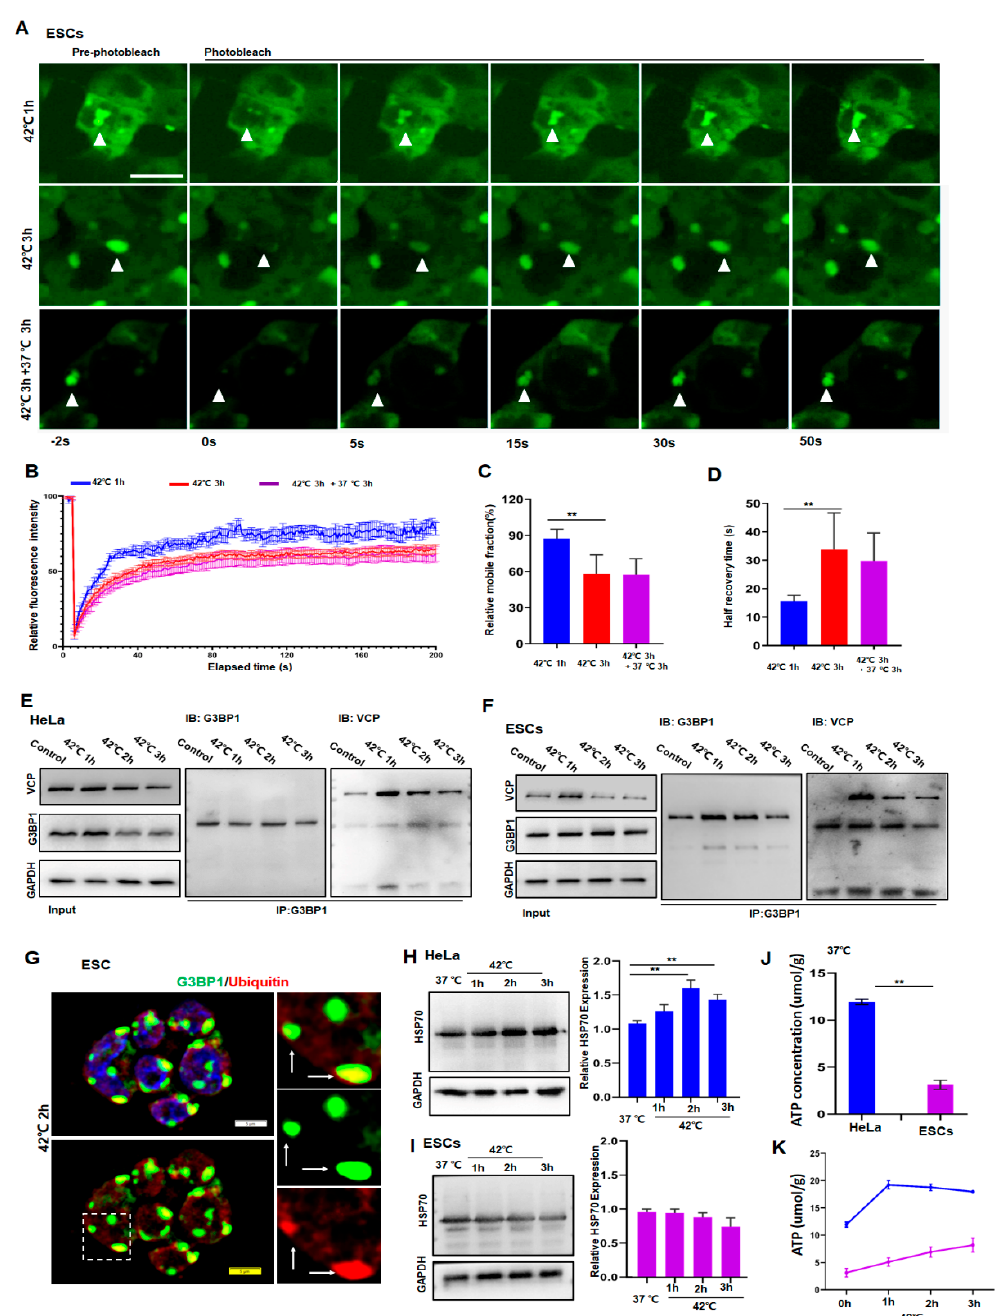
Figure 2. HeLa cells resolved SGs but ESCs failed to do so due to low levels of HSP70 and ATP. ( A , B ) FRAP analysis of G3BP1-SGs in ESCs after 42 ◦ C stress for 1 or 3 h and then recovery for 3 h at 37 ◦ C. n = 15 cells for each group. Mean ± SEM. Scale bar, 10 µ m. ( C , D ) Quantification of mobile fraction and half recovery time in ESCs after 42 ◦ C stress for 1 or 3 h then recovery for 3 h at 37 ◦ C. n = 15 cells for each group. Mean ± SEM. ** p < 0.01 (ANOVA test). ( E ) Immunoblotting of VCP after immunoprecipitation of G3BP1 from HeLa cells after 42 ◦ C stress for the indicated time. ( F ) Immunoblotting of VCP after immunoprecipitation of G3BP1 from ESCs after 42 ◦ C stress for the indicated time. ( G ) G3BP1 and ubiquitin staining in ESCs under 42 ◦ C stress for 2 h. Scale bar, 5 µ m. ( H , I ) HSP70 in HeLa or ESCs under 42 ◦ C stress for the indicated time. Mean ± SEM. ** p < 0.01 (ANOVA test). Original blots see Supplementary File S1. ( J , K ) ATP concentrations in HeLa or ESCs after 42 ◦ C stress for the indicated time. Mean ± SEM. ** p < 0.01 (ANOVA